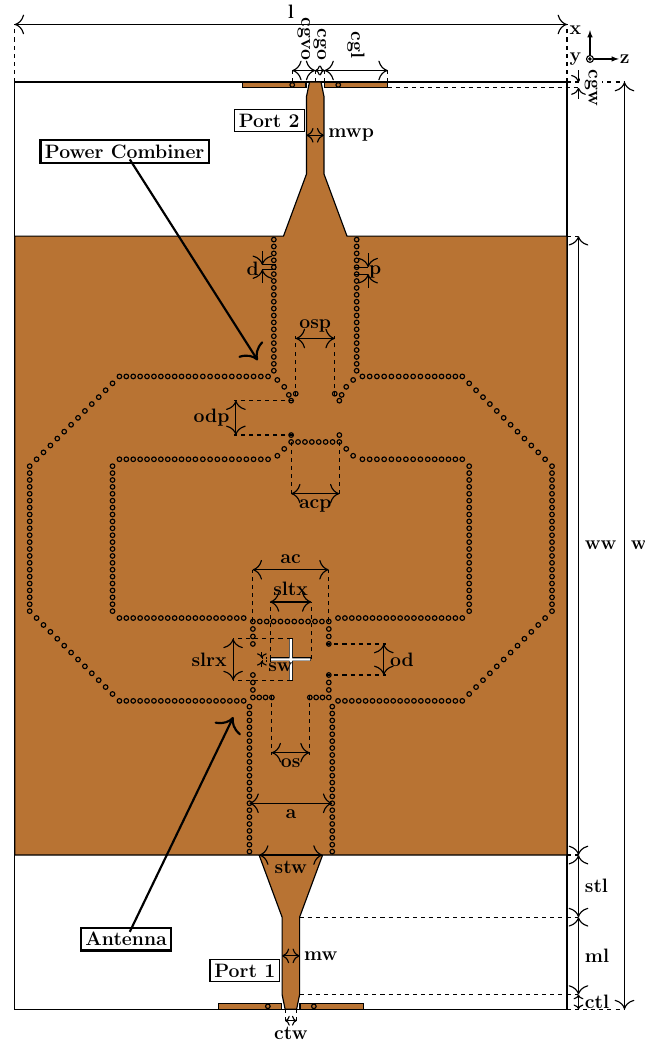
Figure 8. Dimensional view of SIW antenna